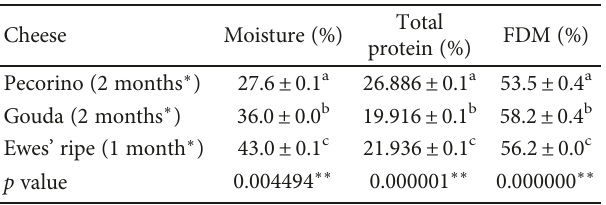
FDM: fat in dry matter. Superscript letters were used to indicate the group classi fi cation. ∗ Ripening time. ∗∗ Means without a common letter are signi fi cantly di ff erent ( p ≤ 0 05